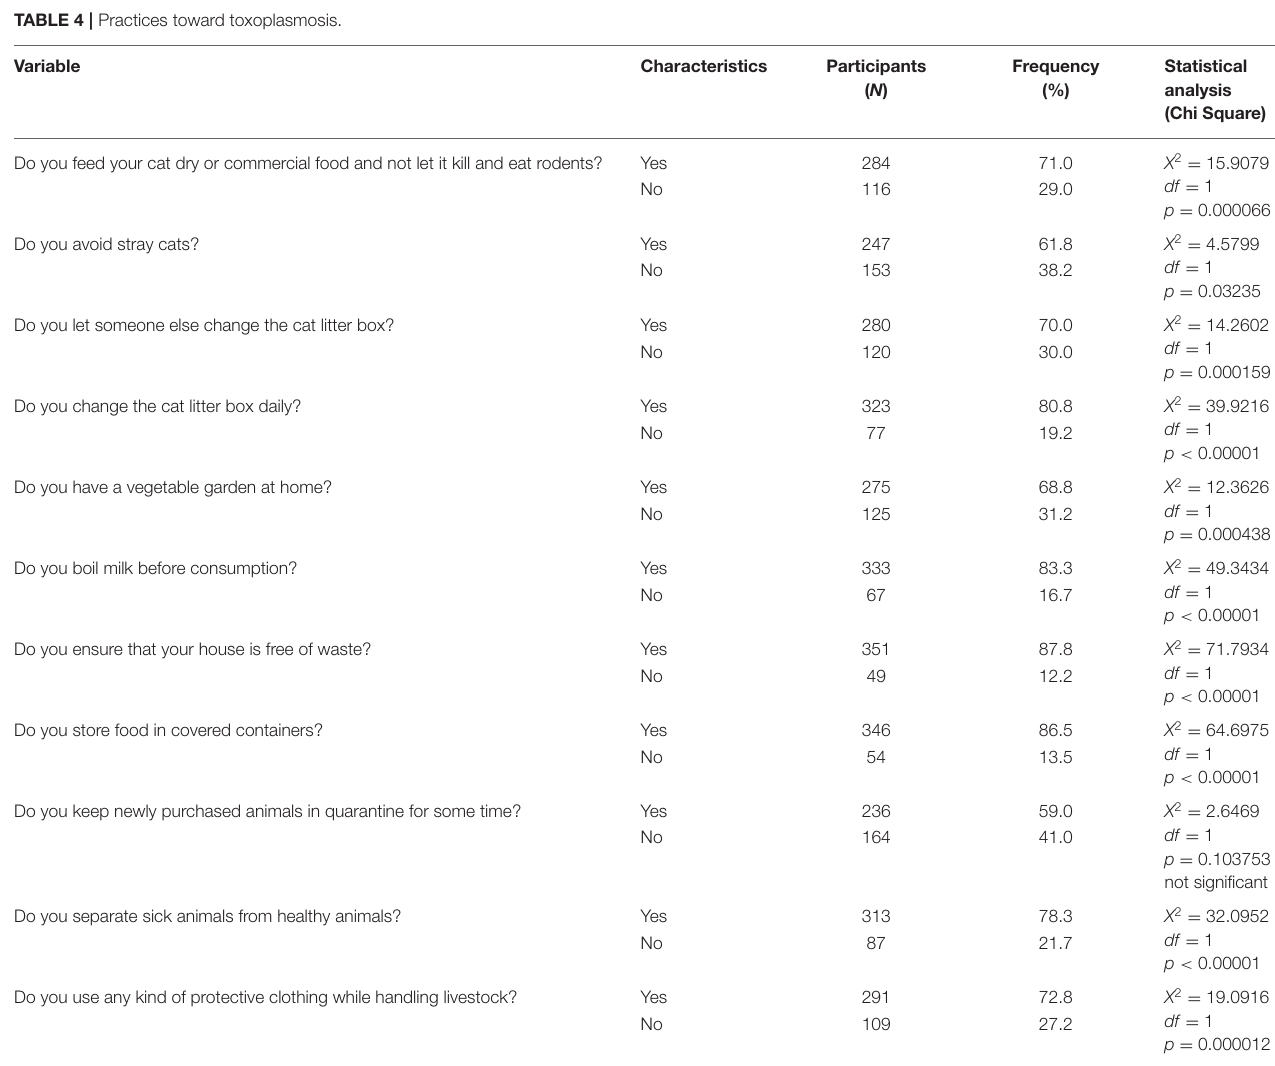
TABLE 4 | Practices toward